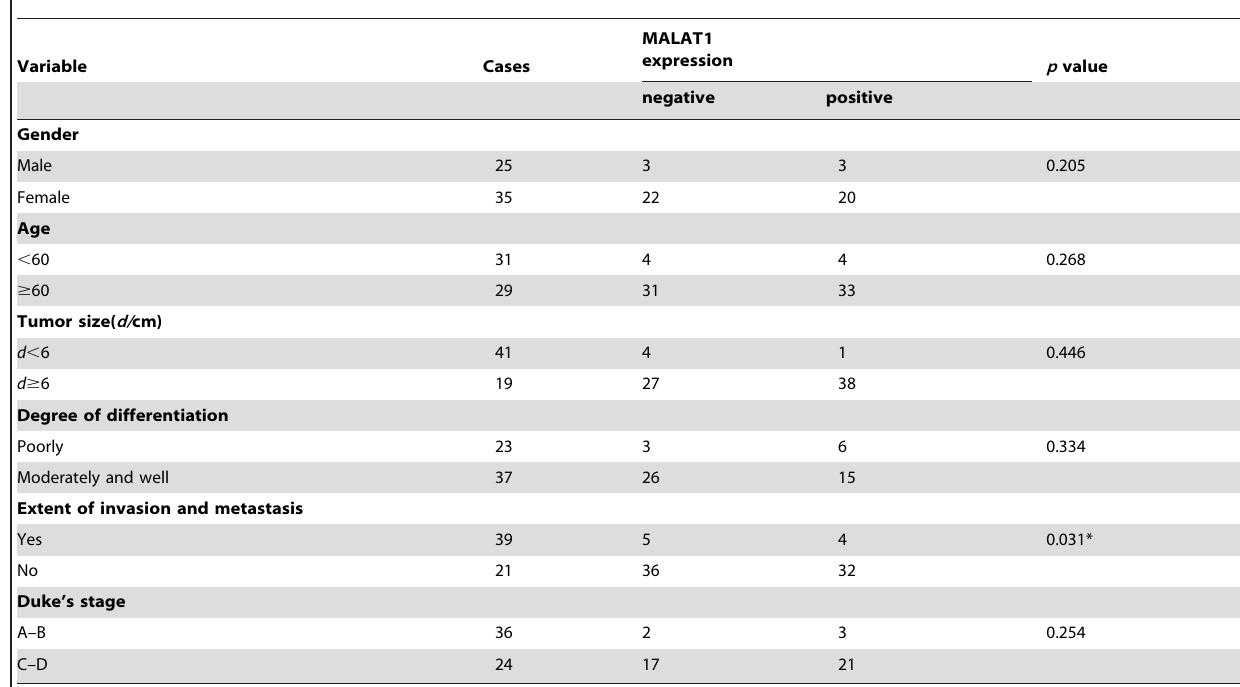
Table 2. MALAT1 overexpression correlates with invasion and metastasis of human CRCs.